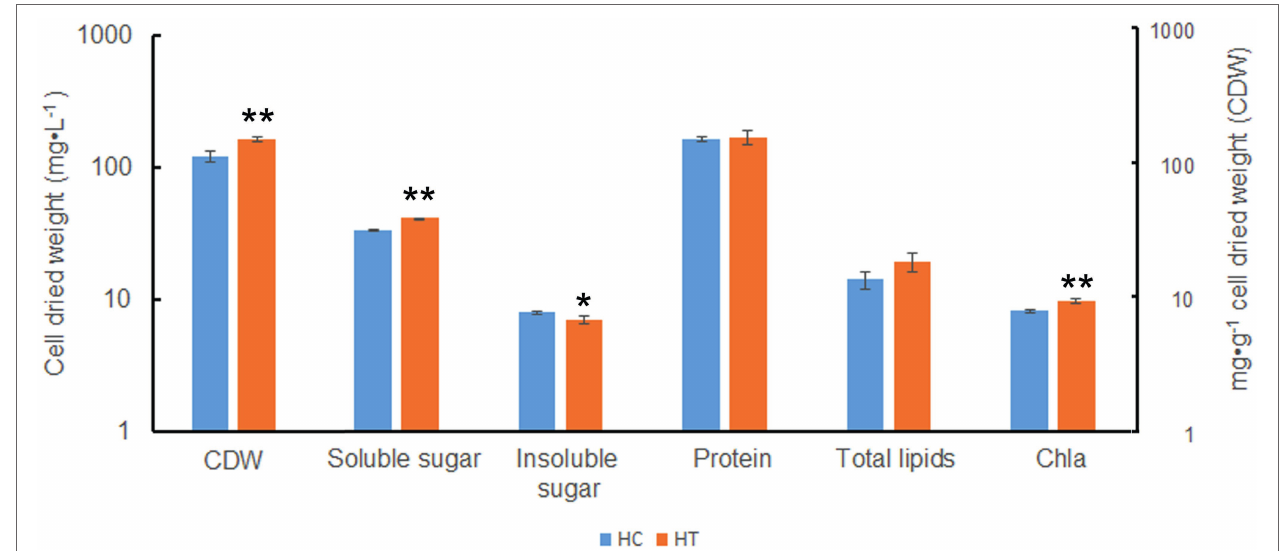
FIGURE 8 | Biomass and cellular components in Symbiodinium sp. under HC and HT conditions. X-axis, group of cellular components; Y-axis, cell dried weight (CDW, indicated as mg·L − 1 ) and cellular component content (indicated as mg·g − 1 cell dried weight). Data points are the means of triplicates and error bars represent the standard deviation. *indicates significant differences (value of p <0.05), **indicates very significant differences (value of p <0.01) between groups evaluated by Student’s t